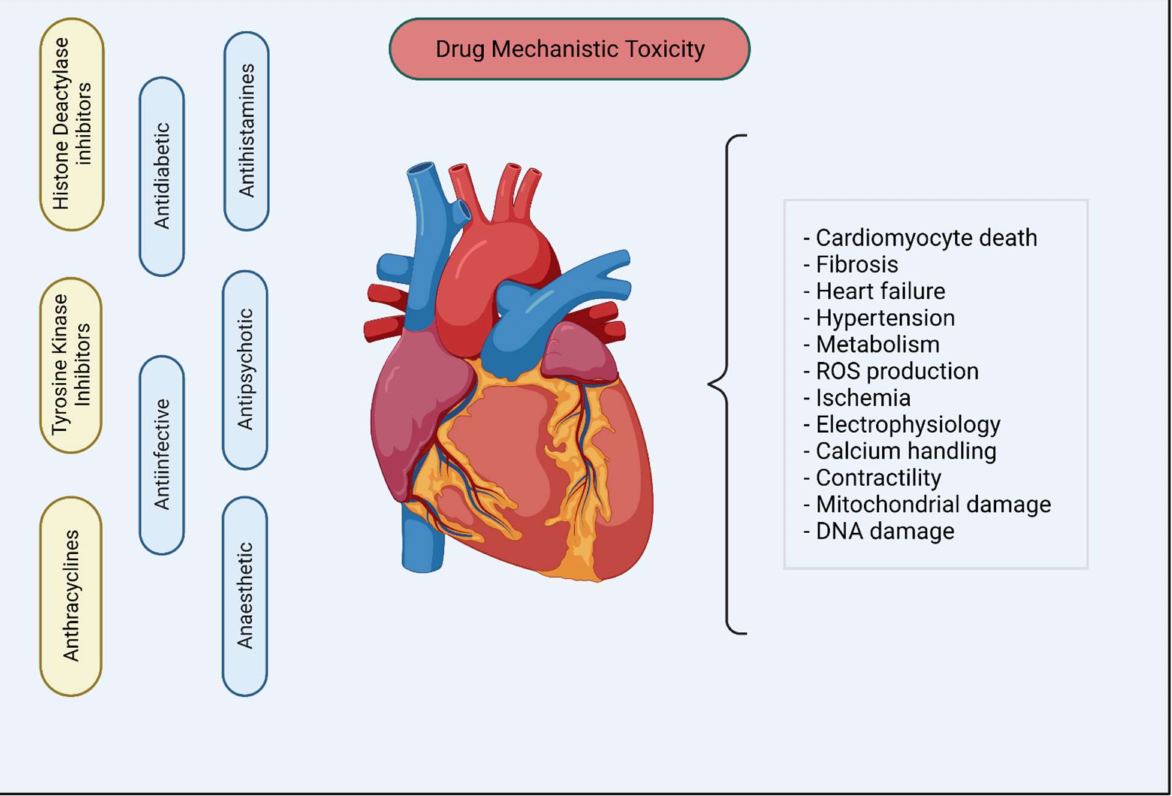
Figure 3. Mechanistic toxicity of anti-cancer drugs and drugs belonging to other indication